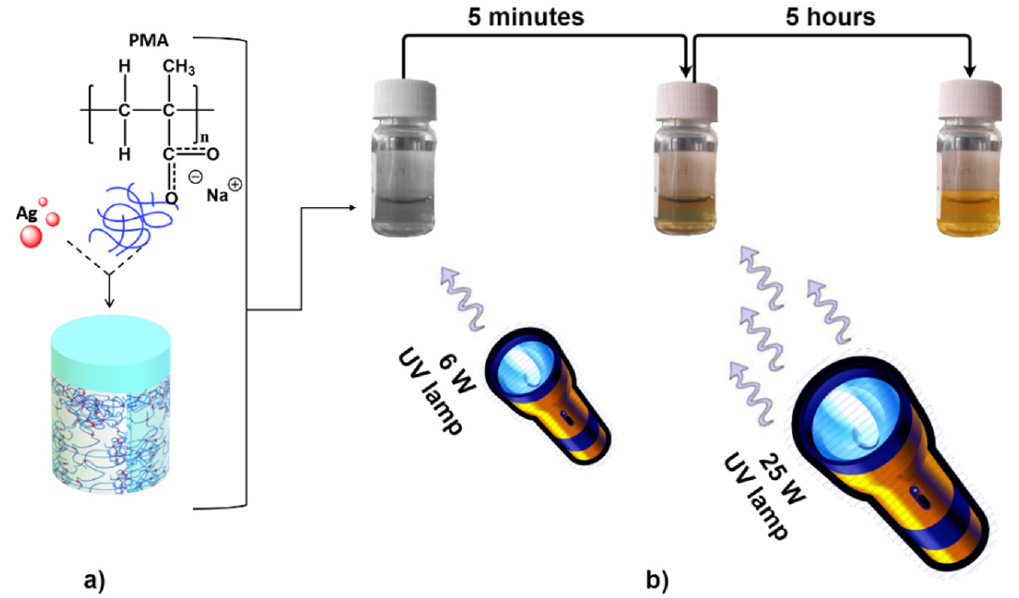
Figure 1. Schematic representation of the Ag-PMA colloid formulation strategy which consists in the dissolution of AgNO 3 powder in PMA solution up to 10:1 molar ratio ( a ), followed by two-steps UV irradiation process ( b ).